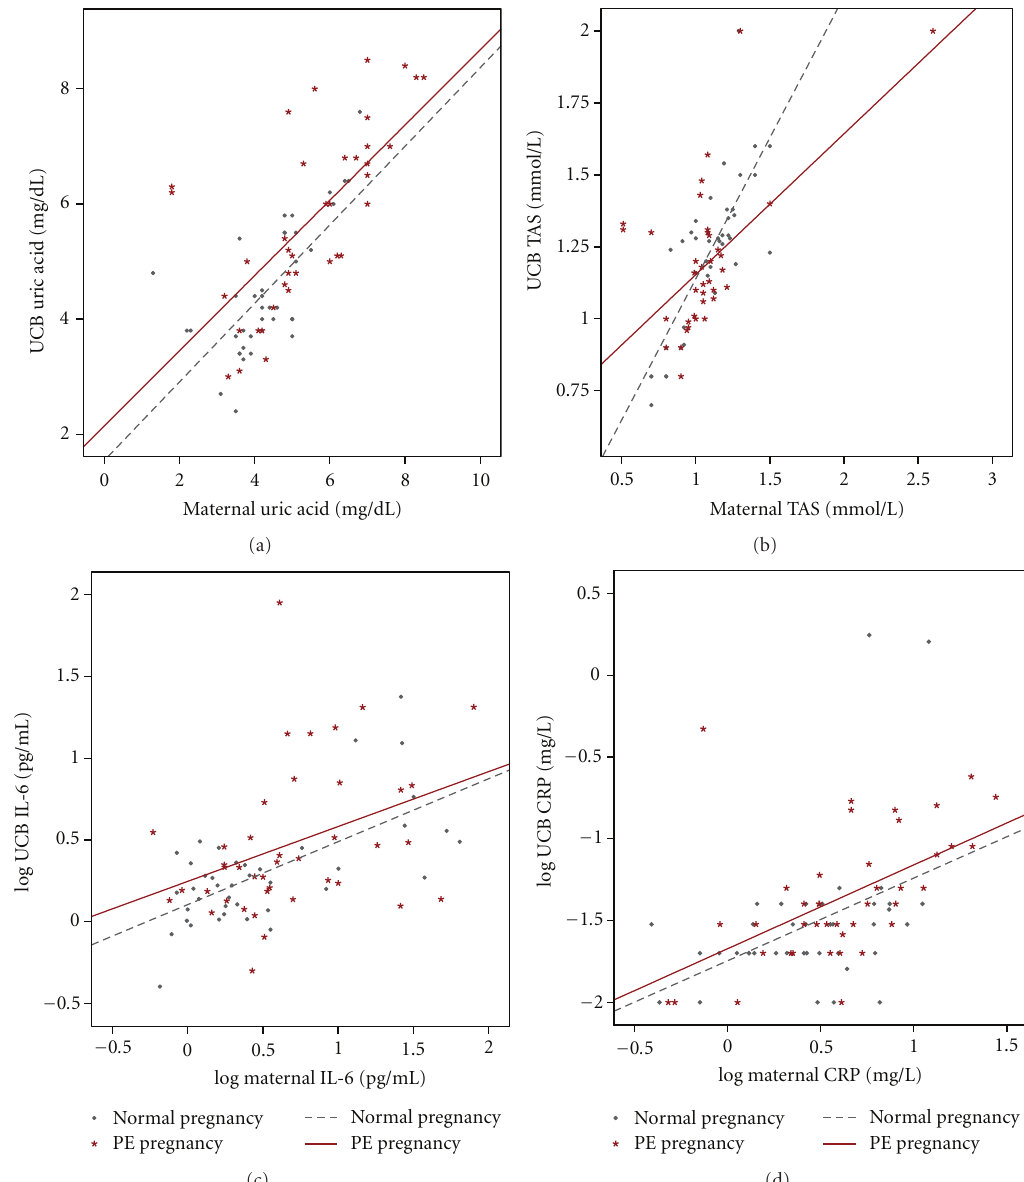
Figure 1: Correlation between maternal and UCB levels of uric acid (a), TAS (b), IL-6 (c), and CRP (d), in normal and PE